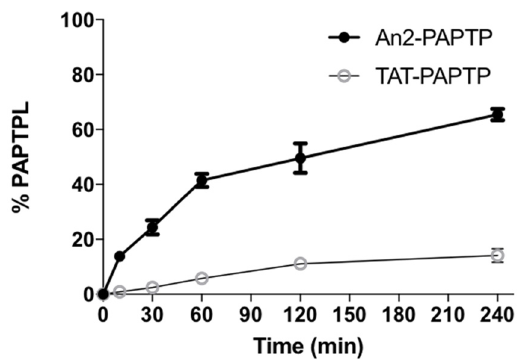
Figure 3. Kinetics of An2-PAPTP and TAT-PAPTP hydrolysis in mouse blood. Data refer to the percentage of PAPTPL released, and are expressed as mean ± SEM. n = 5 and 4, respectively.